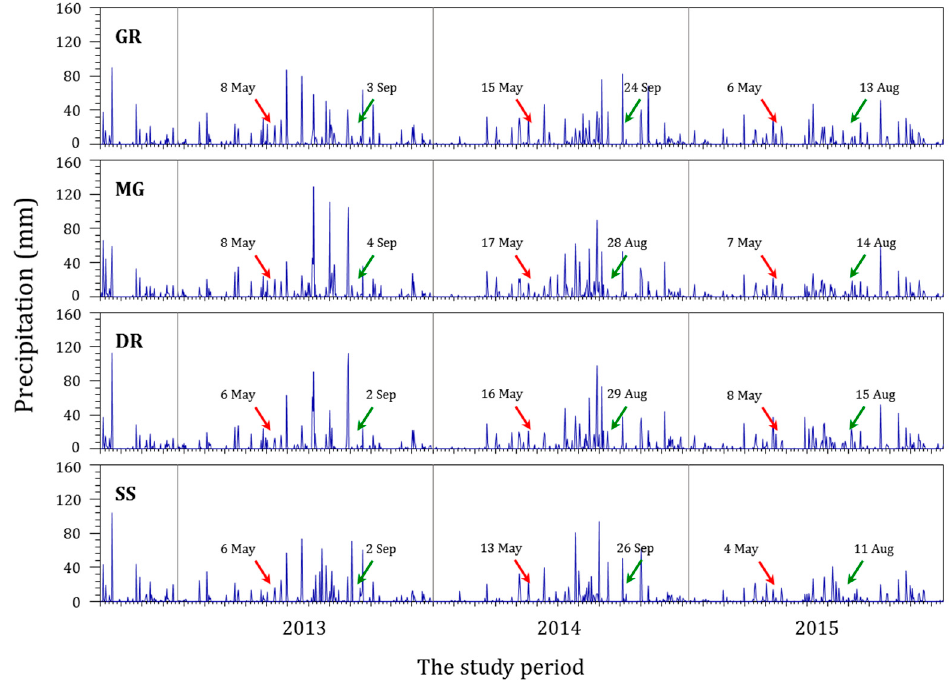
Figure 2. Daily precipitation for the four central western major streams of the Korean Peninsula between 2013 and 2015 (GR: Geumgang River, MR: Mangyeonggang River, DR: Dongjingang River, SS: Sapgyocheon stream). The arrows are sampling dates before (red) and after (green) the monsoon.